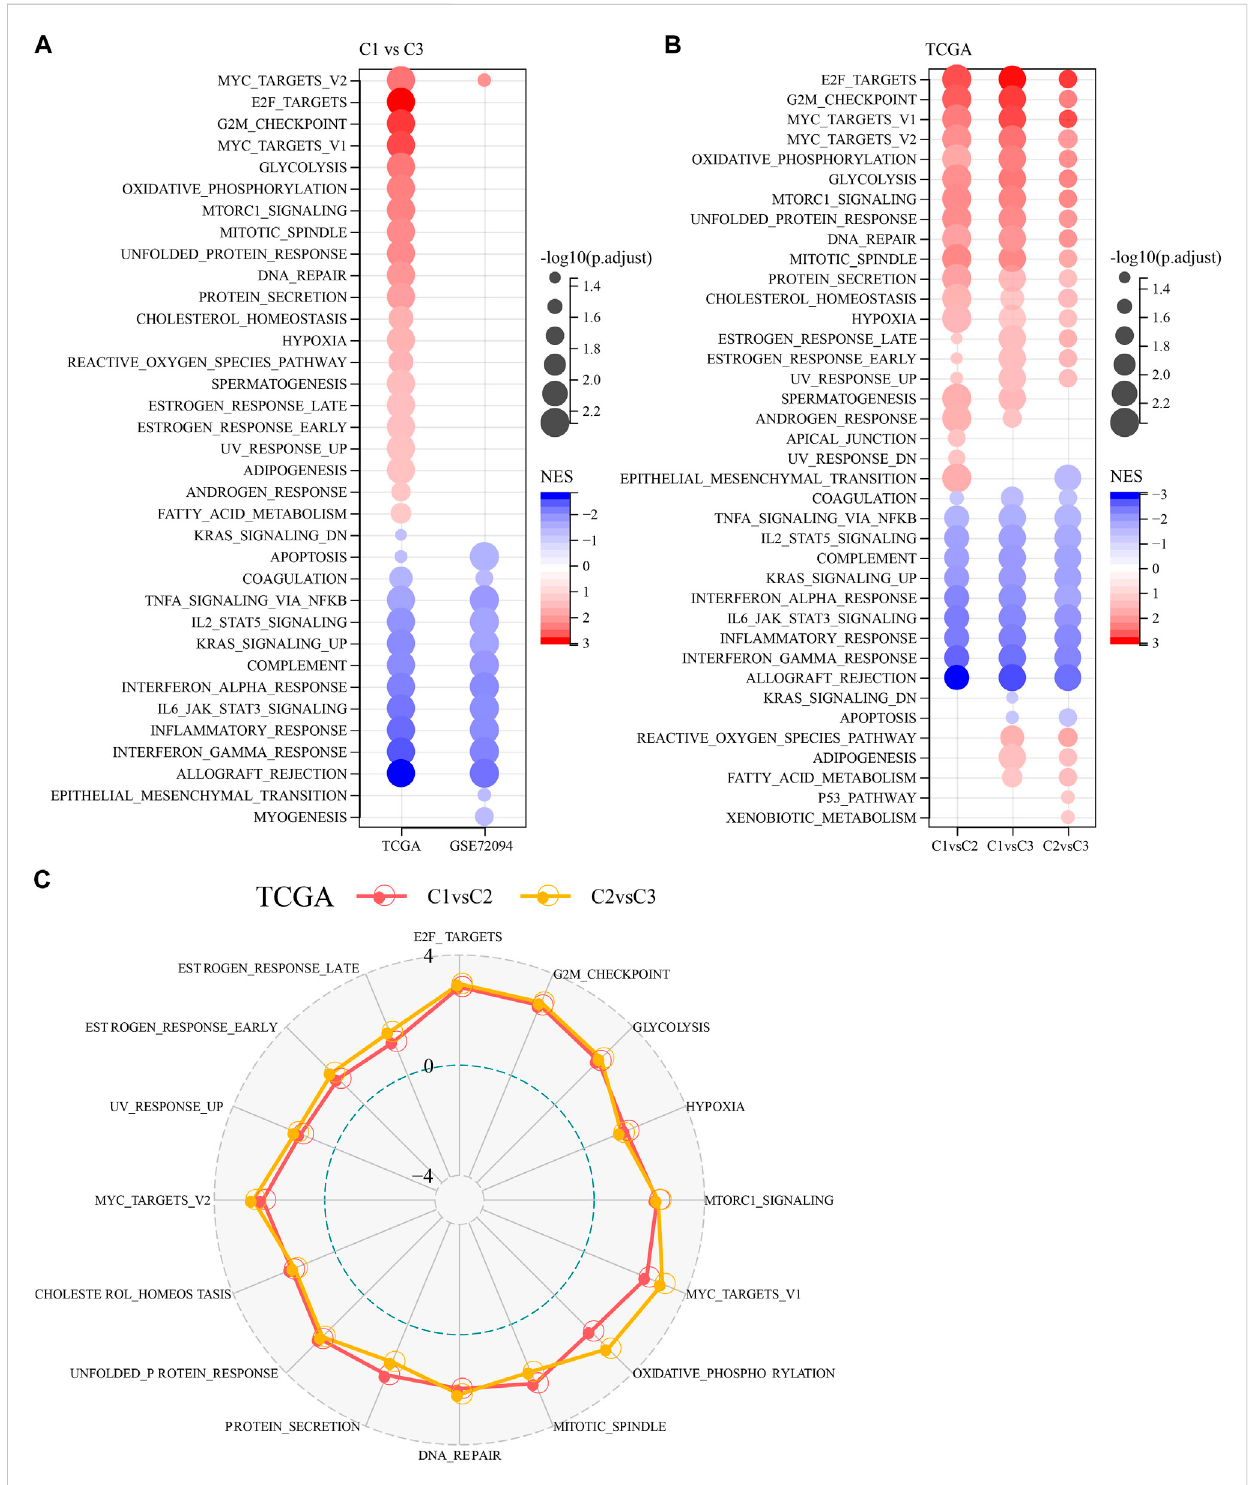
FIGURE 3 Pathway analysis between molecular subtypes. (A) Bubble plots of GSEA results for C1 vs. C3 subtypes in two lung adenocarcinoma cohorts. (B) Bubble plots of GSEA results for different molecular subtypes compared to each other in the TCGA-LUAD cohort. (C) Radar plots of C1 vs. C2 and C2 vs. C3 activation pathways in the TCGA-LUAD